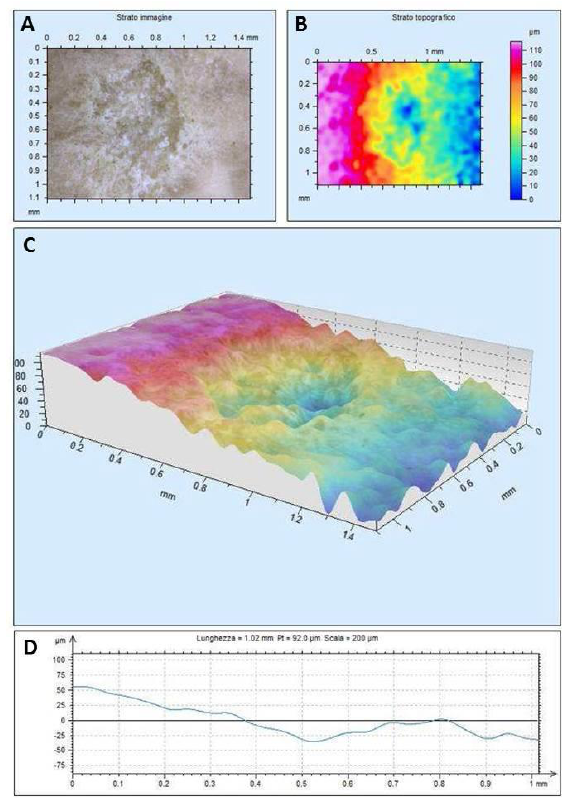
Figure 3. A - DVM multifocal image; B - DVM topographic map; C - 3D topographic rendering; D - Profile of a virtual section of the sample.